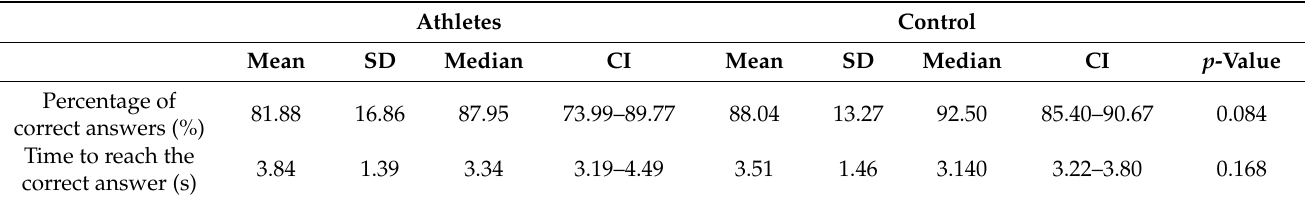
Table 5. “Central tachistoscope” test results.